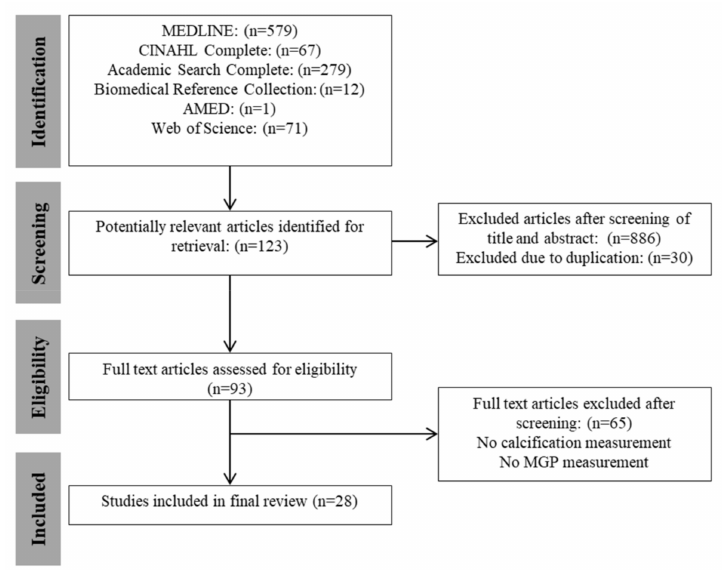
Figure 1. Flow diagram of identification, screening and selection process for included articles in accordance with meta-analysis of observational studies in epidemiology (MOOSE) and preferred reporting items for systematic reviews and meta-analyses (PRISMA). (CINAHL = Cumulative Index to Nursing and Allied Health Literature; AMED = Allied and Complementary